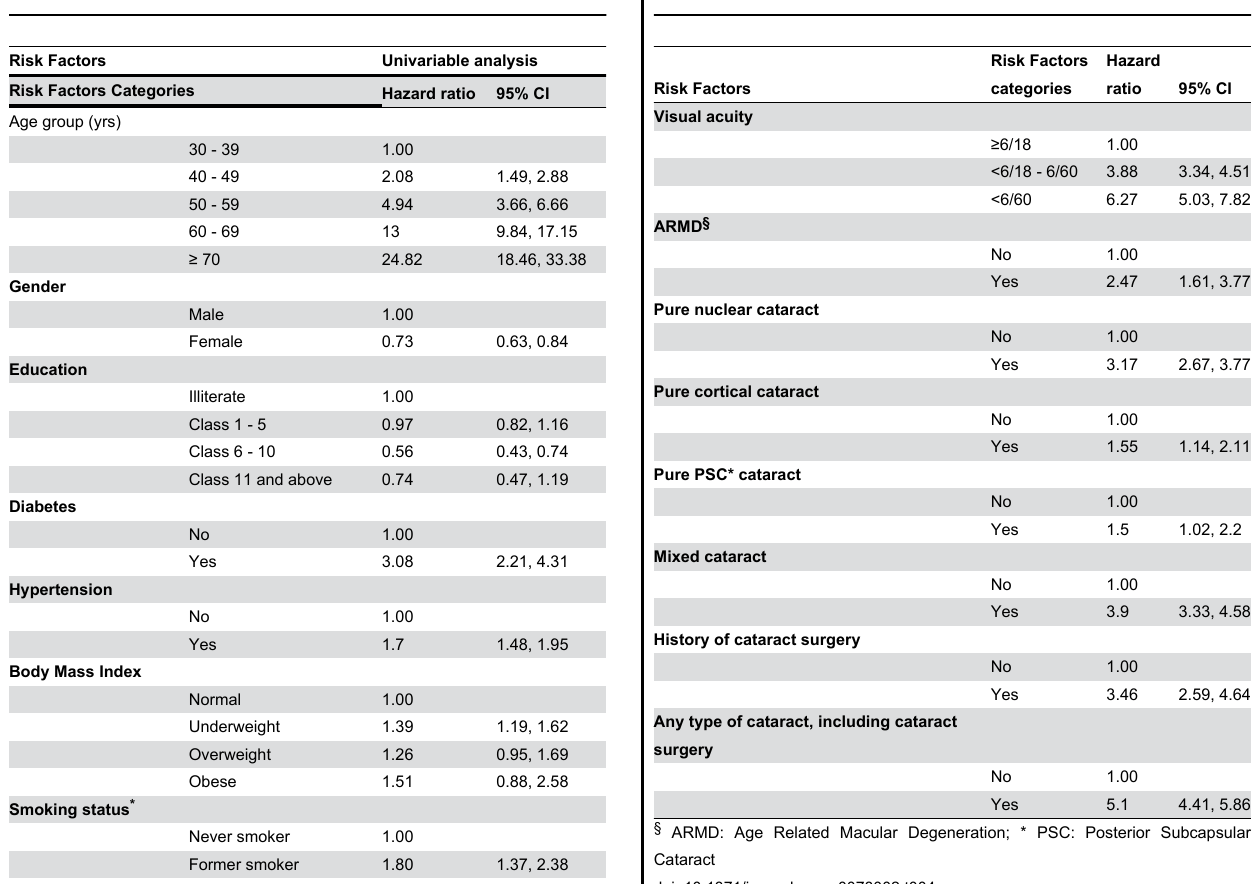
Table 4. Univariable association of ocular factors with subsequent